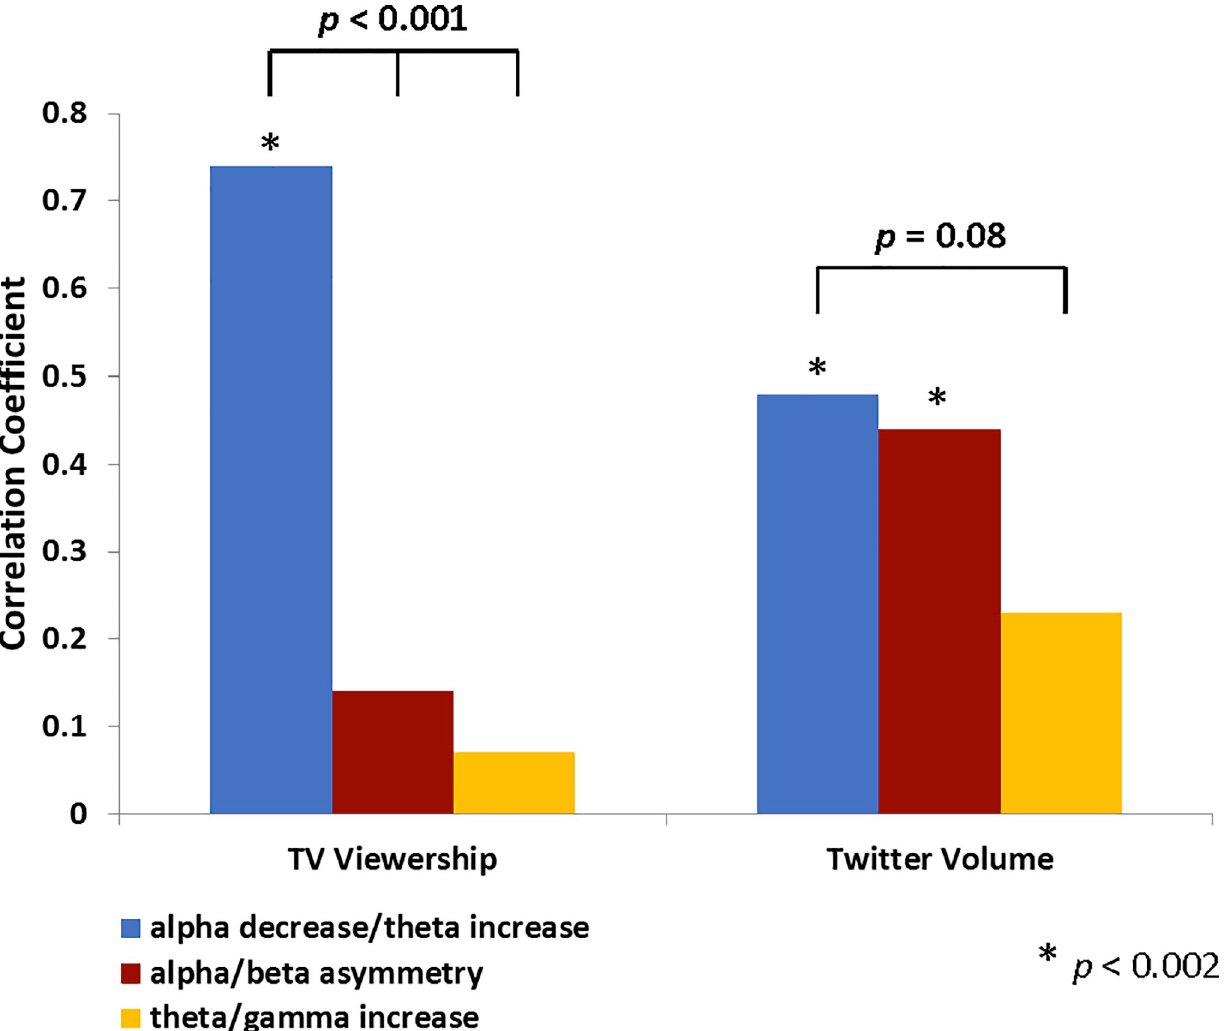
Fig 3. The relationship between individual EEG metrics and TV viewership, Twitter volume. Correlation coefficients were calculated to assess the relationship between individual EEG metrics (n = 49) and TV viewership as well as Twitter volume. Correlation coefficients were computed for fronto- central alpha power decreases/theta power increases typically associated with content-specific attention, alpha/beta asymmetry typically associated with motivational approach, and theta/gamma power increases typically associated with memory processing. The fronto-central alpha power decreases/theta power increases were significant predictors of minute-by-minute changes in both TV viewership and Twitter volume, while the alpha/beta asymmetry was exclusively linked with minute-by-minute changes in Twitter volume.